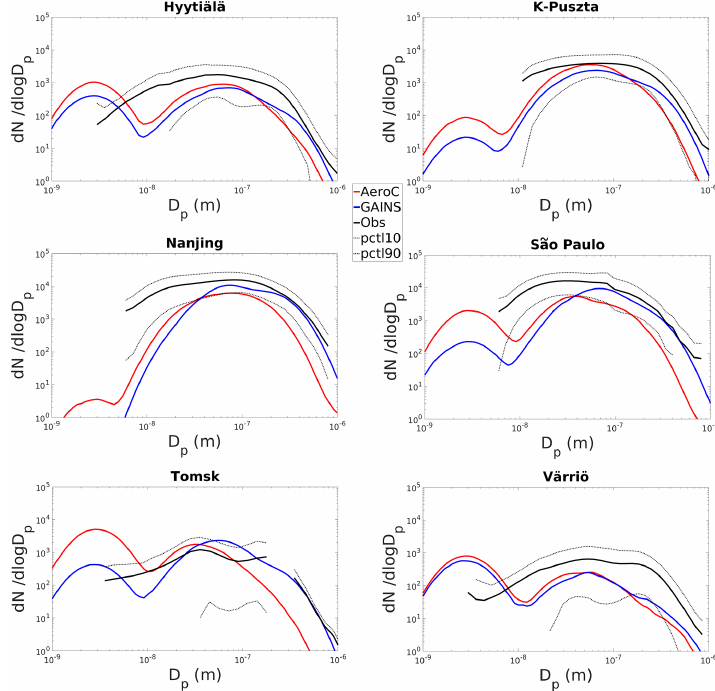
Figure 5. Modeled particle number size distributions compared to observations at six measurement sites.